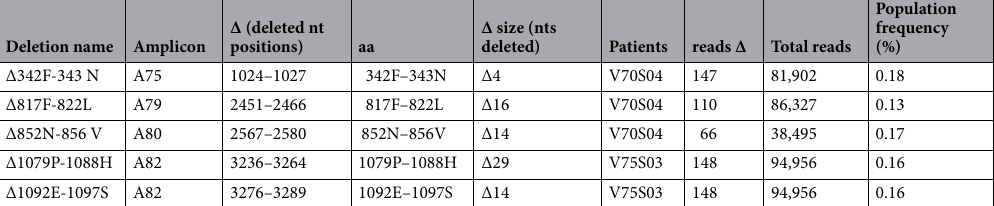
Table 5. Variant B.1.351 (Beta).